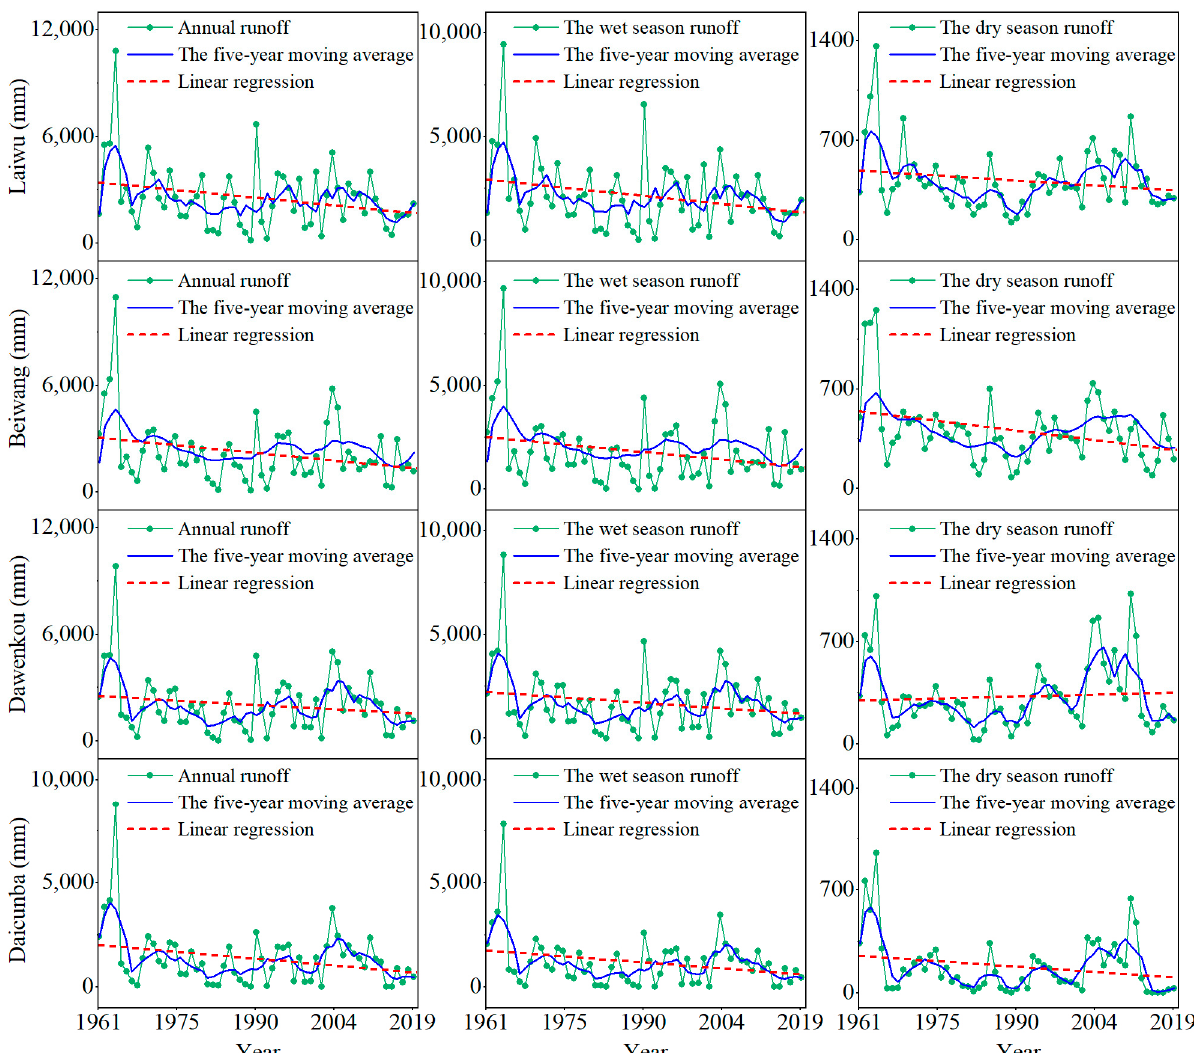
Figure 3. The annual distribution of the runoff in the Dawen River Basin.